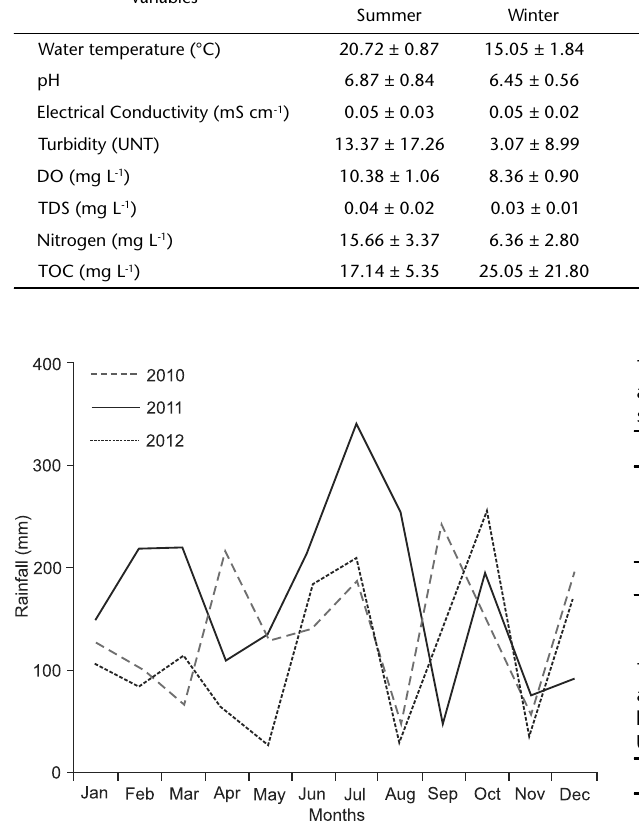
Table 1. Mean and standard deviation of limnological variables quantified the drainage areas of the 10 studied streams in the region Alto Uruguay Rio Grande Sul, in the period 2010-2012. Variables